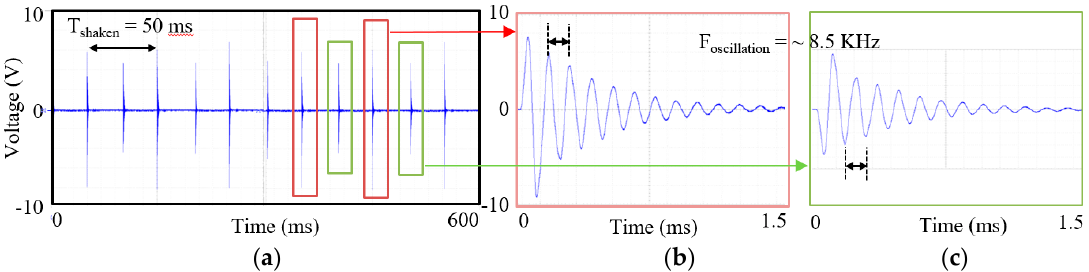
Figure 3. Measured open-circuit voltage at regular force: 20 Hz excitation with 3 g acceleration, ( a ) during 150 ms, ( b ) zoomed bottom-collision voltage during 1.5 ms, and ( c ) zoomed up-collision voltage during 1.5 ms.